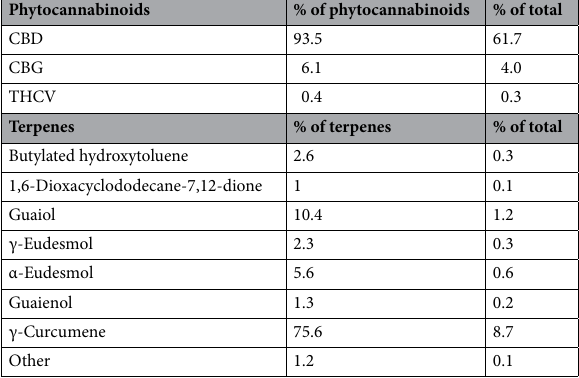
Fig. S6). The increase in percentage of positive cells by F CBD was higher in comparison to the vehicle control also for the fluorescent-labeled silica 30–70 nm particles (ENP) and for the IgG coated, fluorescent-labeled silica 30–70 nm particles (ENPG). F CBD:std and CBD treatments were less effective in increasing internalization (for FNP) or presence (ENP and ENPG) of the particles in cells in comparison to the F CBD treatment (Table 3; Sup- plementary Fig. S6).